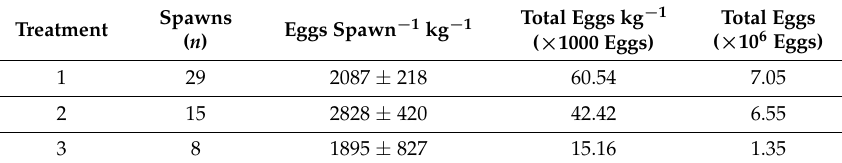
Figure 5. Daily fecundity (eggs kg − 1 female body weight (BW)) and fertilization (%) of F1 greater amberjack in response to three treatments with GnRHa implants. The white arrows on the X -axis indicate the times of the GnRHa treatments. Table 3. Egg production (mean ± SEM where appropriate) of F1 greater amberjack induced to spawn using a GnRHa implant treatment at different times during the reproductive season (May–July). No statistically significant differences were observed among the means of relative batch fecundity obtained after the three GnRHa treatments ( p <